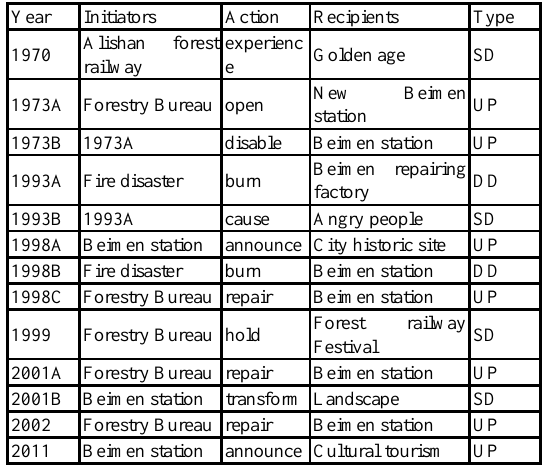
Table1. Events of Beimen station from 1723-2013